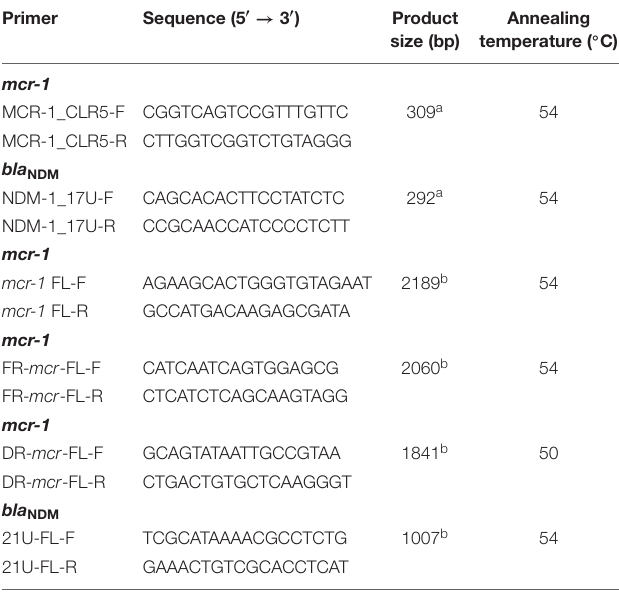
TABLE 1 | The primers for screening and ORF amplification of the mcr-1 and bla NDM